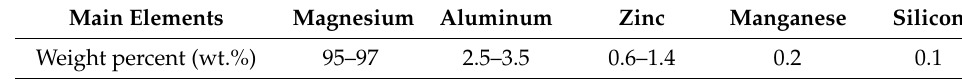
Table 1. Chemical composition of AZ31 alloy.